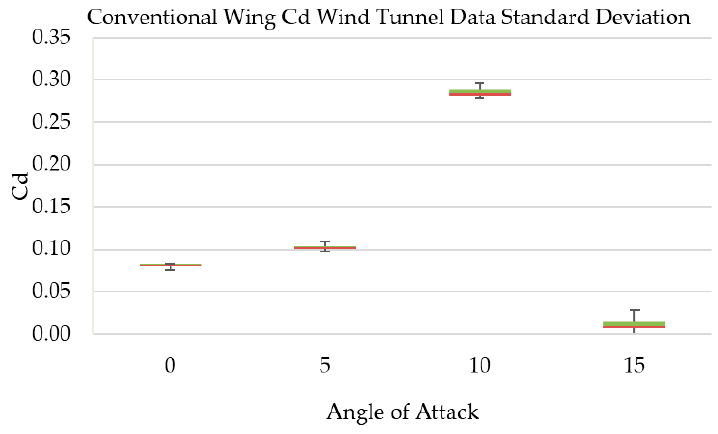
Figure 4. Conventional wing drag coefficient wind tunnel data standard deviation.